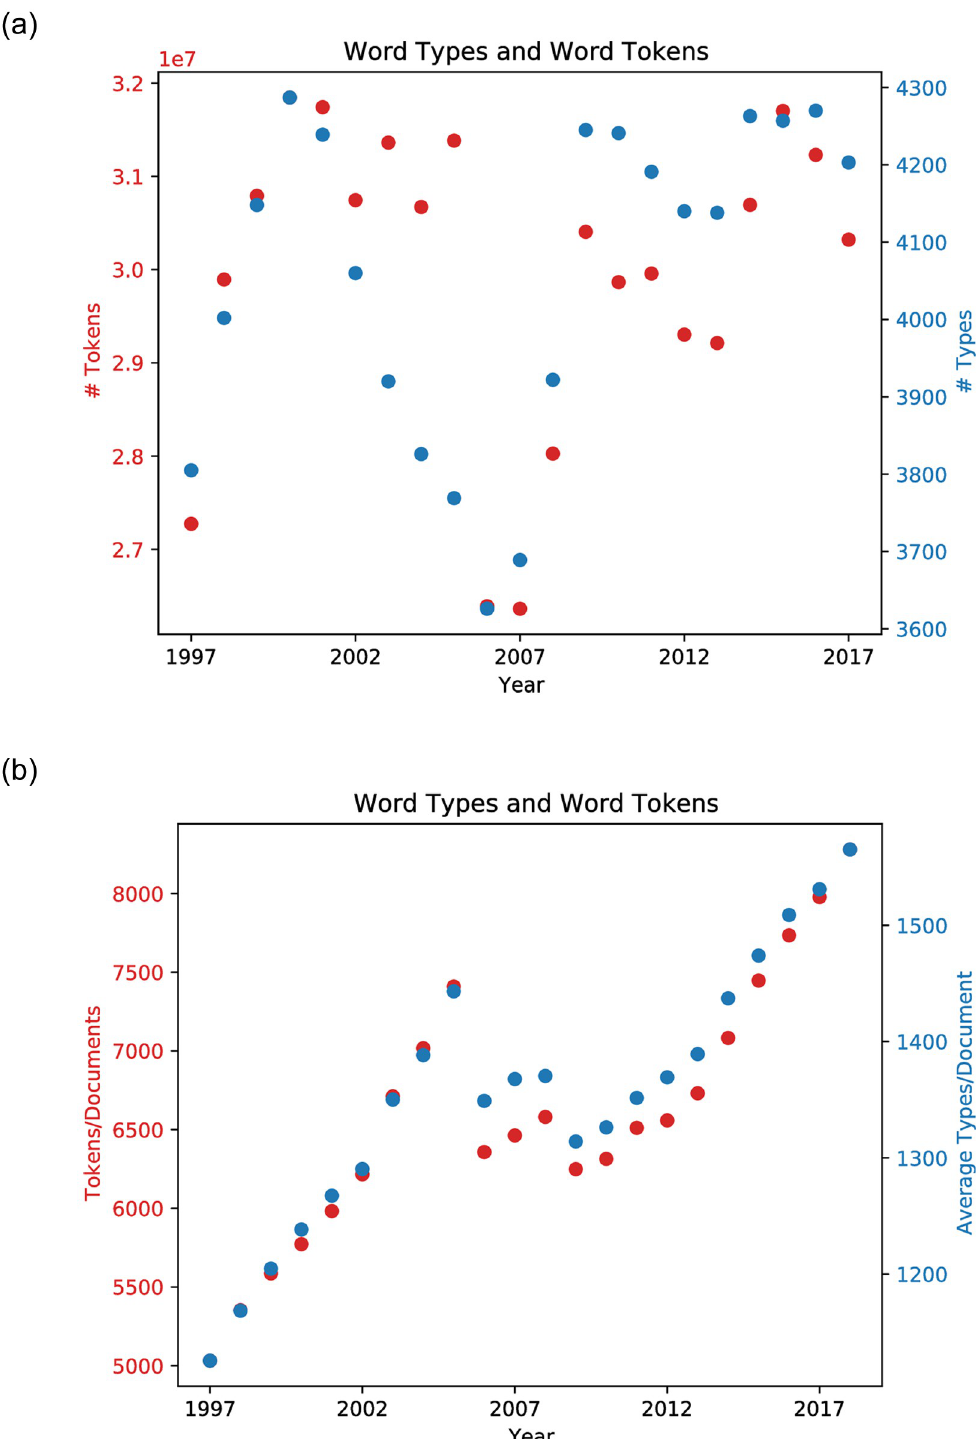
Fig 6. Left: The number of word tokens and word types in annual batches of 10-K documents in training corpus, during the first two decades of this century. Right: The mean number of word tokens and types in each document in each batch, over the same